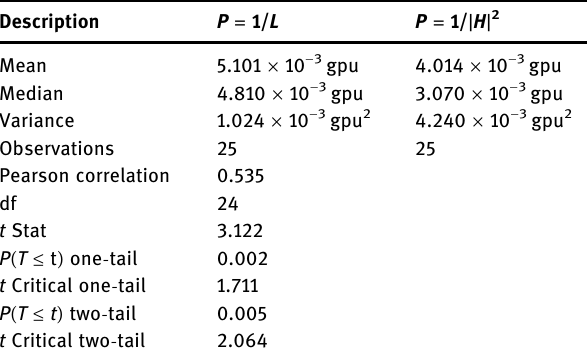
Table 2: t - Test: Paired Two Sample for Means using the samples of the mean errors of the benchmark derived from the adjustments based on weights ( 3 ) and ( 8 )